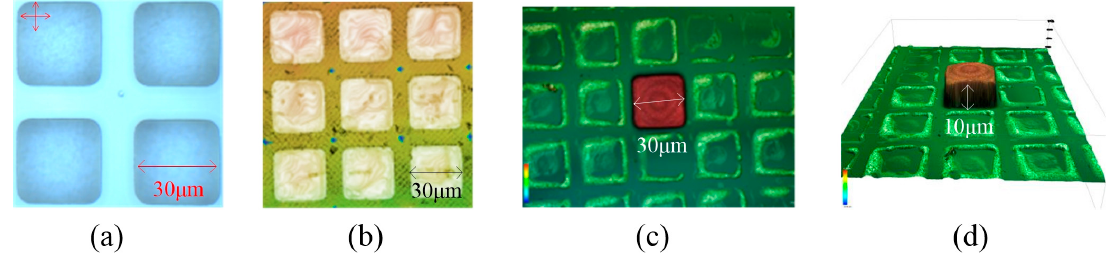
5 of 10 Figure 3. F abrication process of polymer cholesteric liquid crystals (PCLC) flakes using soft lithography. 2.4. Characterization and Measurements The phase transition temperatures of the mixtures were studied using Differential Scanning Calorimeter (DSC, METTLER DSC 1, Mettler Toledo, Inc., Zurich, Switzerland). The heating and cooling rates were both 2 ° C/min. Optical images between crossed polarizers were taken using a polarized optical microscope (POM, Leica DM 2700 P, Leica Microsystems Ltd., Wetzlar, Germany). Transmittance spectra of the reflectors were measured using an Ocean Optics spectrometer 2000 PRO. The surface topography of PCLC flakes was measured using a 3D surface profilometer (Leica DCM8, Leica Microsystems Ltd., Wetzlar, Germany). In order to release PCLC flakes, we immersed the PDMS mold filled with flakes in water and shook it using the ultrasonic cleaner (SG3200HBT, Shanghai Guante ultrasonic instrument co., Ltd., Shanghai, China). The status of flake release was checked every minute. When there were no flakes left on the mold, the total ultrasonic time was recorded as the release time of the PCLC flakes. 3. Results and Discussion 3.1. Characterization of Shaped Flakes The shape, alignment, and morphology of the PCLC flakes with 30 μ m × 30 μ m size in the PDMS mold with 0.5 μ m PVA layer were studied, as shown in Figure 4. From the POM image of the flakes (Figure 4a), we can see that the PCLC flakes can copy the shape of the PDMS molds exactly. We can also see that the PCLC alignment inside the flake is not perfect; there are some dark dots that represent domains with different alignment directions, especially near the edges. This is because there is no alignment layer in the PDMS mold, but the LCs tend to align parallel at the interface with PDMS and PVA. This is conflicting with the rotational tendency of the cholesteric liquid crystals at the edges, so the alignment is not very uniform. When the size of flakes becomes larger, the influence of the edges becomes smaller and the alignment is better. In order to learn more about the morphology of the PCLC flakes, we used a 3D profilometer to observe the topography of the PCLC flakes. From Figure 4b, we can see that the major part of the PCLC flakes surface is flat, but there are